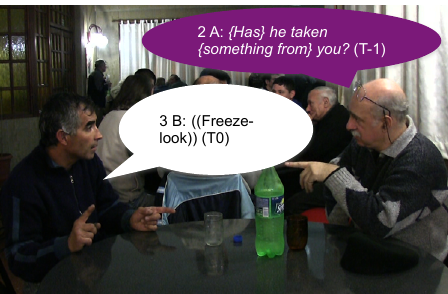
Figure 35. {Has} he taken {something from} you? , in line 4 Person A, on the right, solves the problem by repeating the entire question produced in line 2 (Figure 4) to Person B. Person B, on the left, holds still his body position until almost the end of the repetition of the